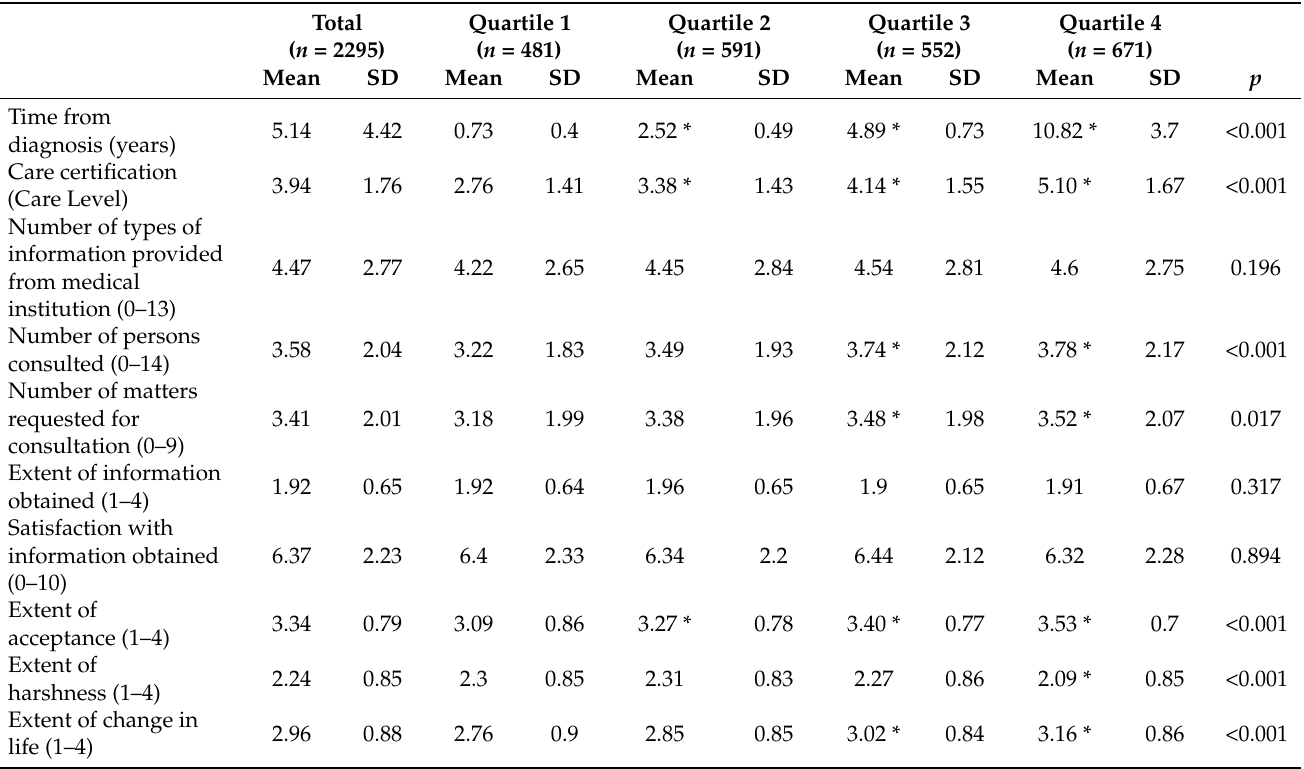
Table 2. Information acquired, consultations sought by, and psychological situations of family caregivers according to time from